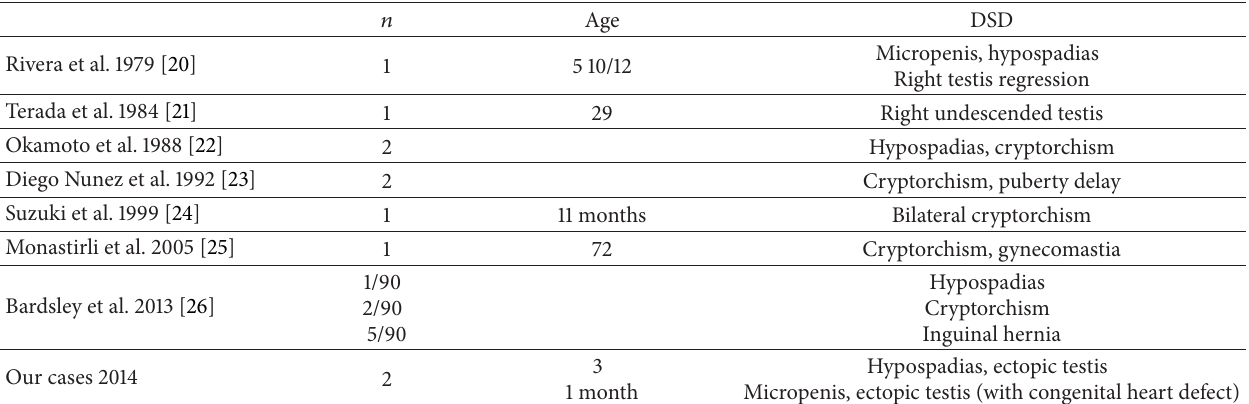
Table 1: Disorder of sexual development in a patient with 47XYY.